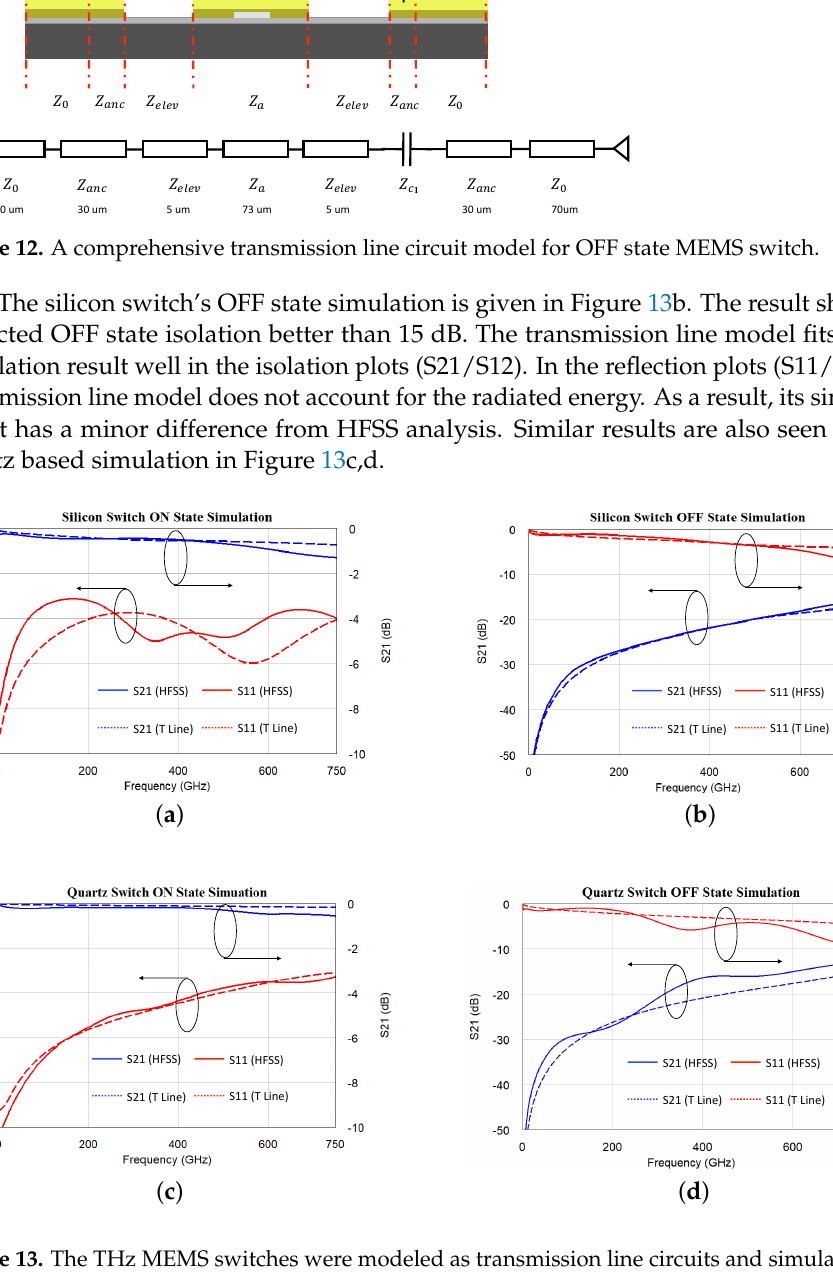
Figure 13. The THz MEMS switches were modeled as transmission line circuits and simulated using AWR Microwave Office (marked as T line). The circuit simulation results are compared with ANSYS HFSS finite element analysis. ( a ) Silicon based design at the ON state. ( b ) Silicon based design at the OFF state. ( c ) Quartz based design at the ON state. ( d ) Quartz based design at the OFF